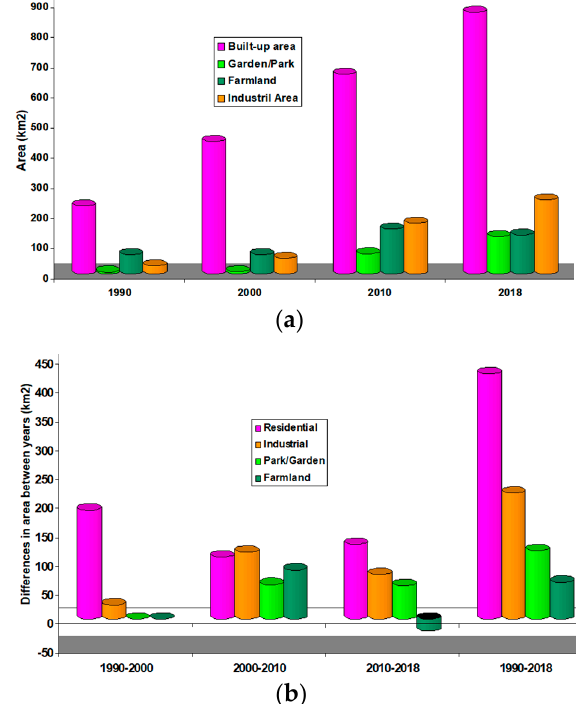
Figure 8. The graphical representation of the total area in km 2 of built-up and vegetated area changes ( a ), and their differences from 1990 to 2018 ( b ).